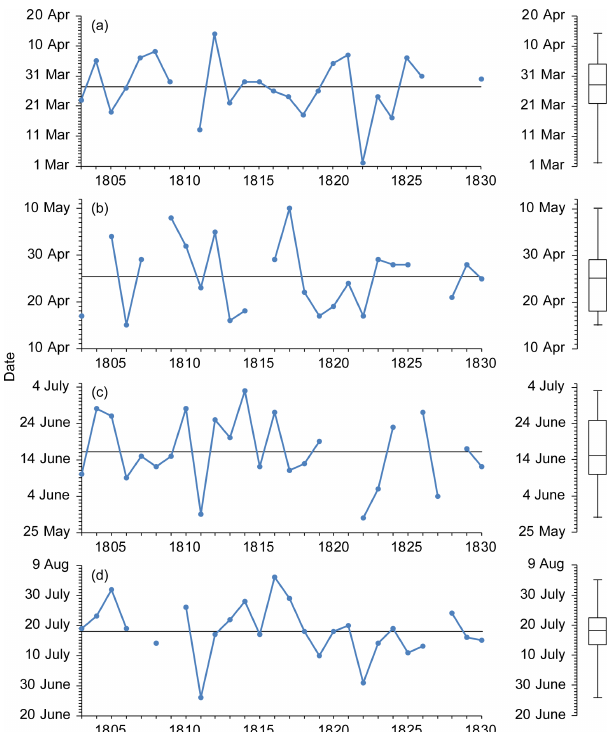
Figure 9. Fluctuations (left) and box plots (right) of the beginnings of selected phenophases and agricultural work at Buchlovice during 1803–1830 derived from the weather diary kept by Šimon Haus- ner: (a) spring sowing of cereals; (b) blossoming of cherry trees; (c) blossoming of grapevine; (d) grain